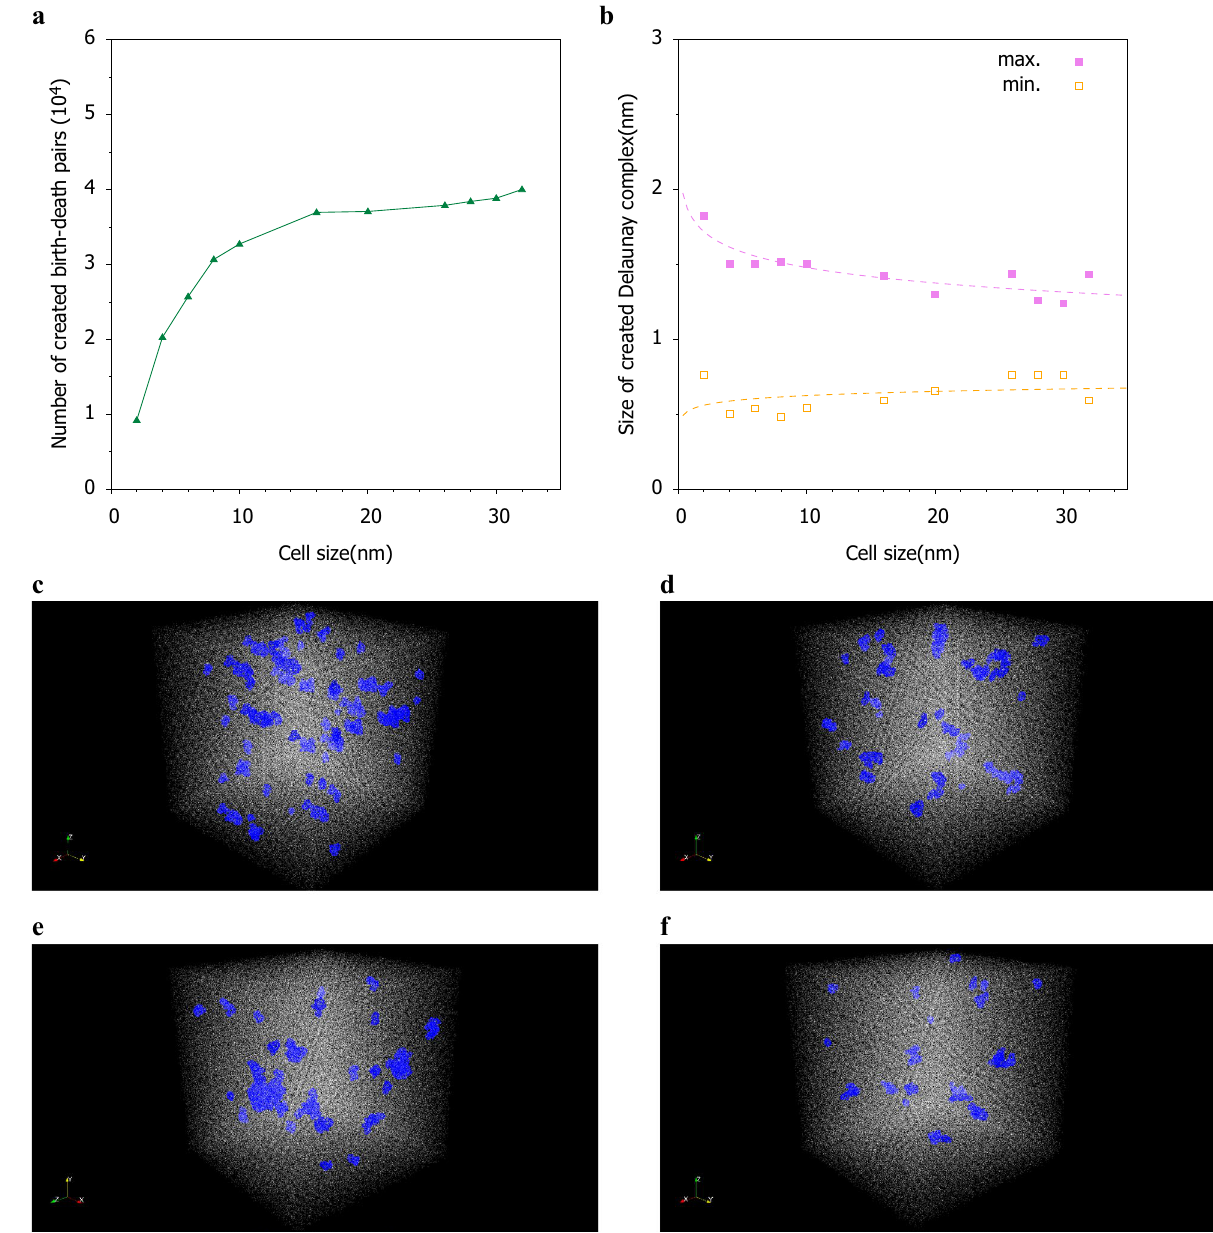
Figure 7. The change of Delaunay complexes and inverse analysis in Sample 1 (a) Relationship between the cell size and created birth-death pairs. (b) Relationship beween the cell size and maximum or minimum size of created Delaunay complexes. Inverse analysis results of Delaunay complexes distributions in real space expanded to 20 nm cell. (c) Inverse analysis results of Delaunay complexes distributions in real space in 2 nm cell expanded to 20 nm cell, (d) Similar 4 nm expanded to 20 nm, (e) Similar 10 nm expanded to 20 nm, (f) Similar 20 nm without